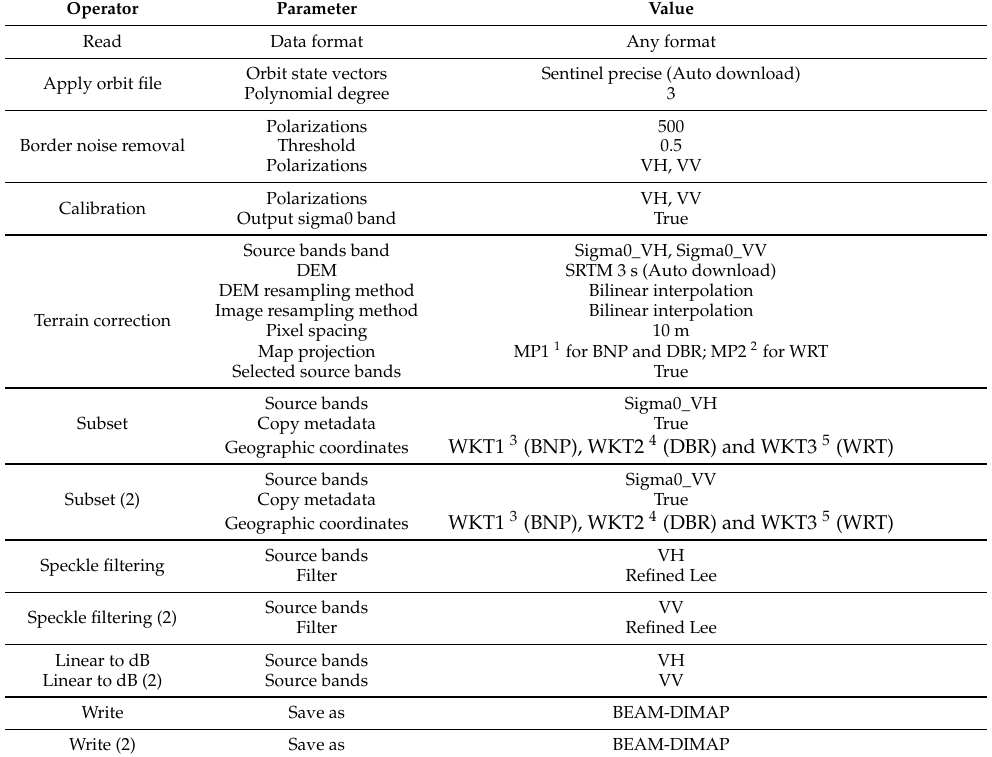
Table 2. The parameters used for each